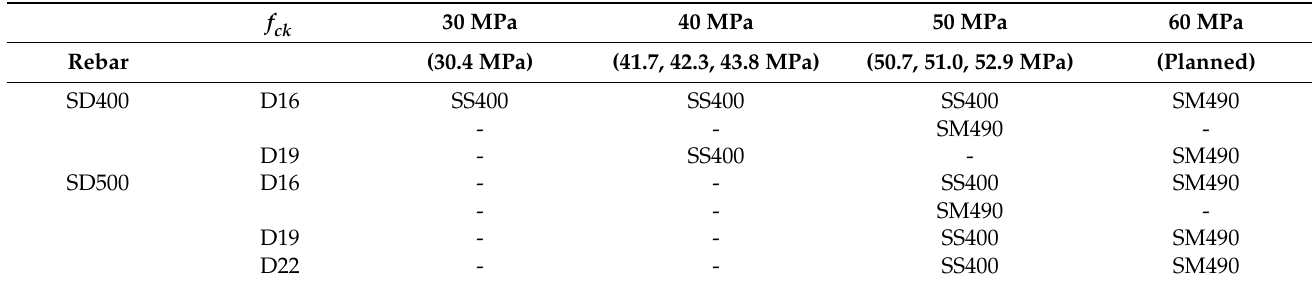
Table 1. Design variables of previous specimens [4,17–22].